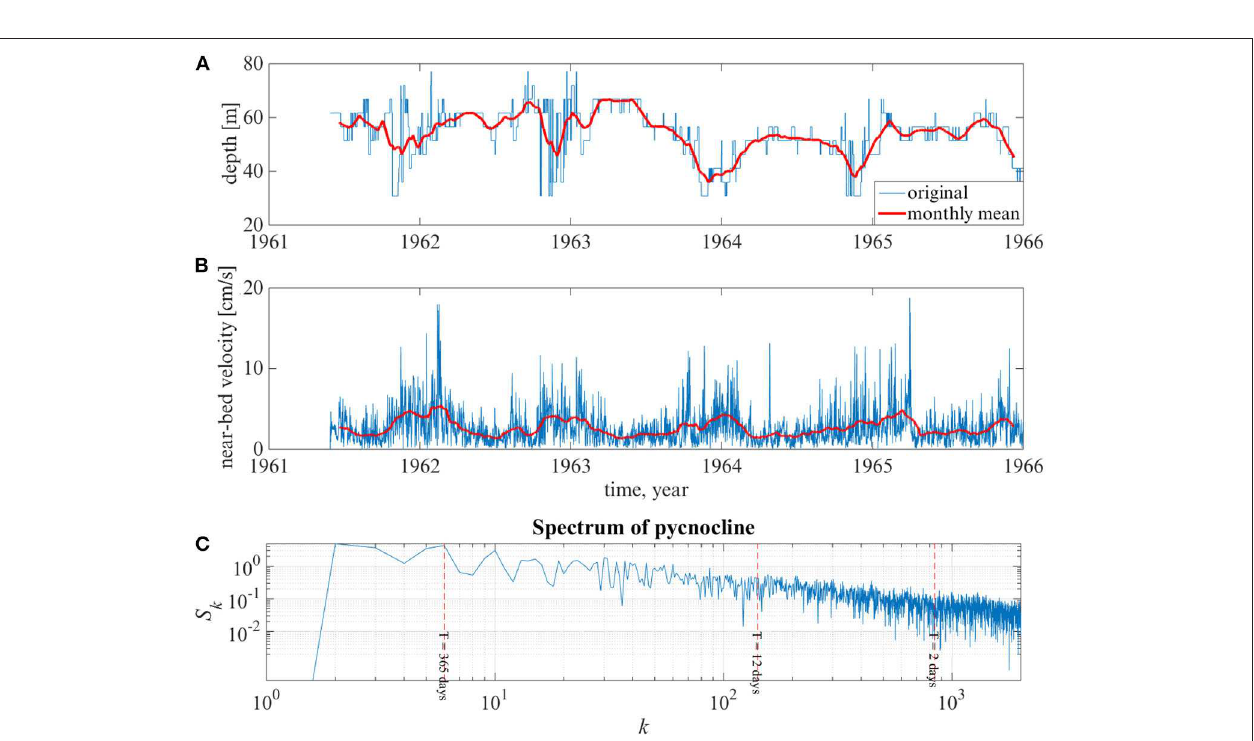
FIGURE 4 | Vertical location of the seasonal (upper line) and main (permanent) pycnocline (lower line) 18.35 ◦ E, 58.01 ◦ N (point 23 in Figure 3 ) in 2000–2005. Thin lines represent the locations of the jump layer with a resolution of 6h whereas the bold lines present the monthly moving average. Note that the restriction for the main pycnocline (below 30m) and for the seasonal pycnocline to be located above this level may lead to an artificial separation of the two jump layers during certain time intervals (e.g., December 2001 or November 2005).